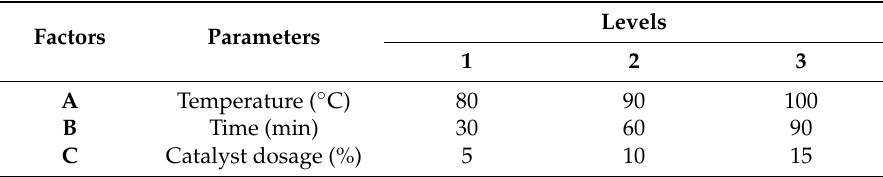
Table 1. Investigated factors and the corresponding